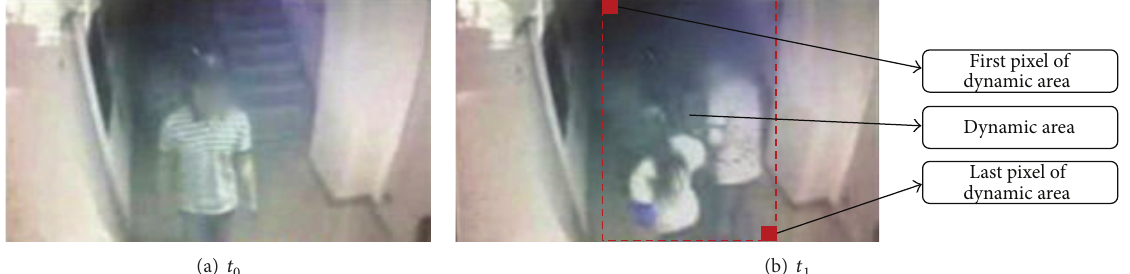
Figure 4: Detection of the dynamic area and extraction of the transmission area.